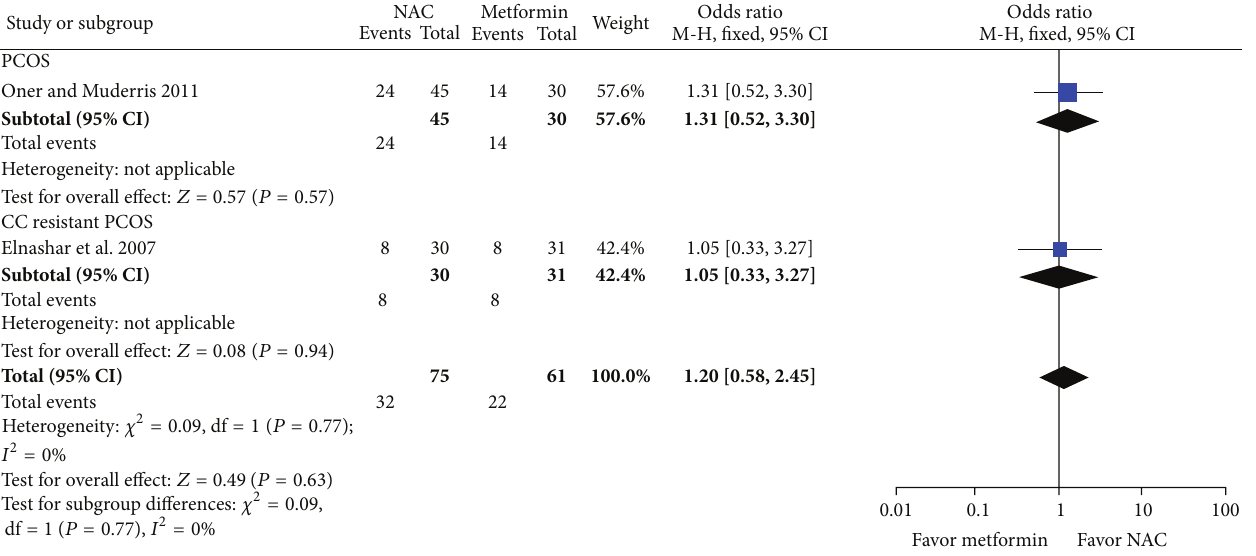
Figure 5: Forest plot: outcome: pregnancy rate in women with PCOS comparing NAC with